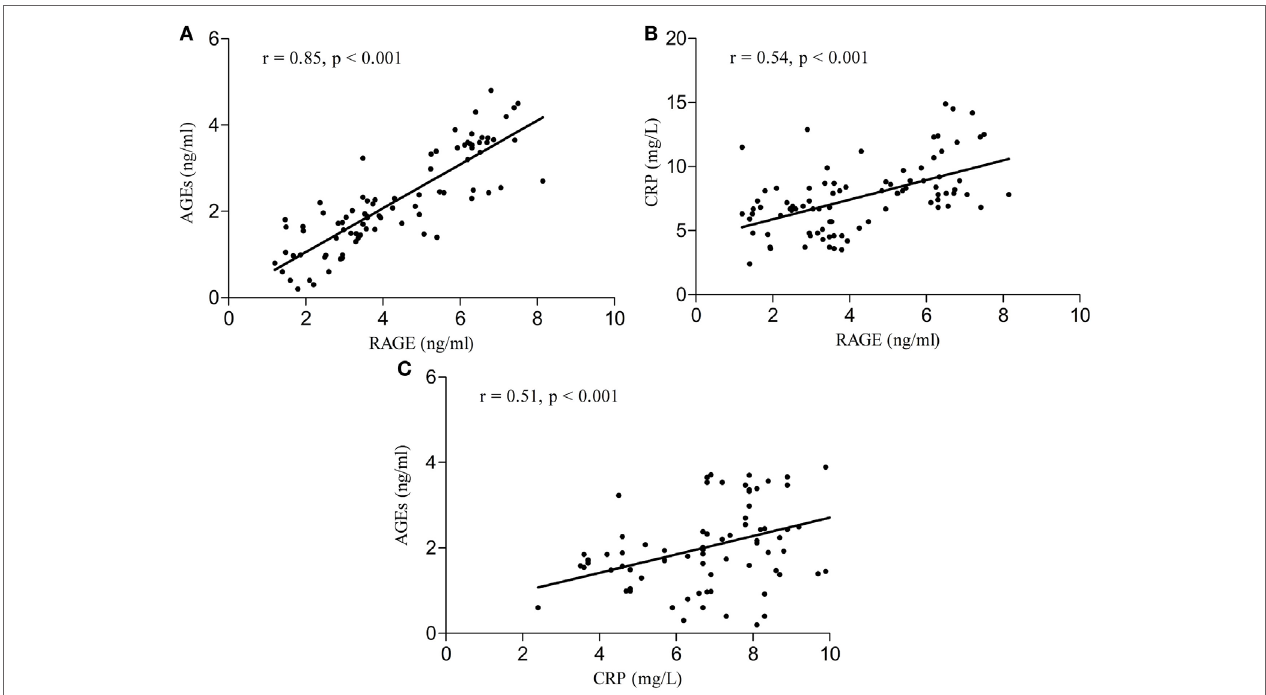
FigUre 1 | (a) Correlation of RAGE with AGEs in group of diabetic elderly patients with MCI. (B) Correlation of RAGE with CRP in group of diabetic elderly patients with MCI. (c) Correlation of AGEs with CRP in group of diabetic elderly patients with